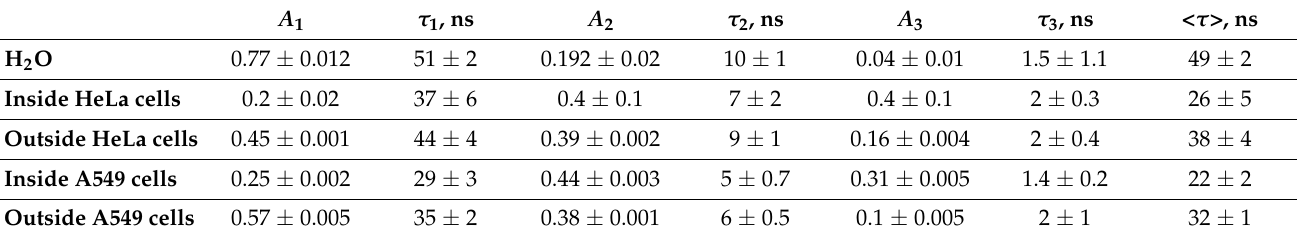
Figure 7. Fluorescence-lifetime imaging microscopy (FLIM) of HeLa and A549 cells incubated with InP-QDs ( a ): Typical FLIM images of control cells and cells after incubation with InP-QDs (20 nM, 24 h). QD-positive clusters inside (endolysosomes) and outside the cells (aggregates) are marked with arrows. Insets represent enlarged views (5 × ) of the boxed region. ( b ): InP-QD decay curves obtained from FLIM images presented at ( a ) with QDs inside and QDs outside the cells compared to the water. The parameters of these approximations are given in Table 2. ( c ): Statistical analysis of PL lifetimes of 50 individual QD structures per experimental point inside and outside of HeLa and A549 cells from three independent experiments. Data are presented as box plots. In box plots, whiskers represent the minimum and maximum values, bases represent the interquartile range between the first (red) and third quartiles (green), and midlines represent the median. Point symbols indicate the mean value. Table 2. Three-exponential fit parameters of the observed PL decay of InP-QDs interacting with HeLa and A549